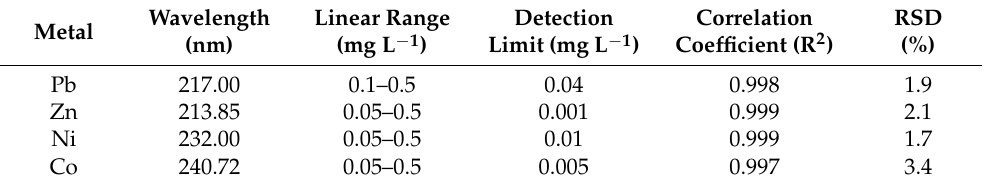
Table 2. Calibration results for the determination of heavy metals in e-cigarettes.